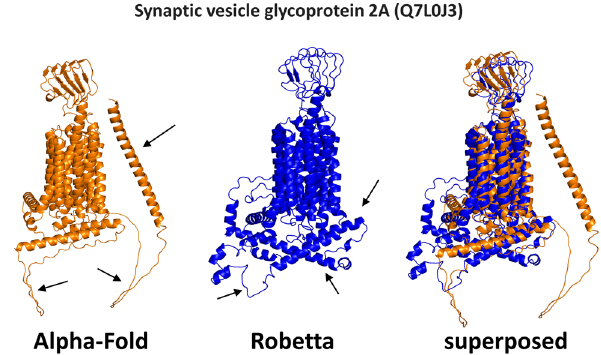
Figure 5: Comparison of AlphaFold and Robetta for the synaptic vesicle protein SV2A. The arrows indicate the main di ff erences between AlphaFold and Robetta